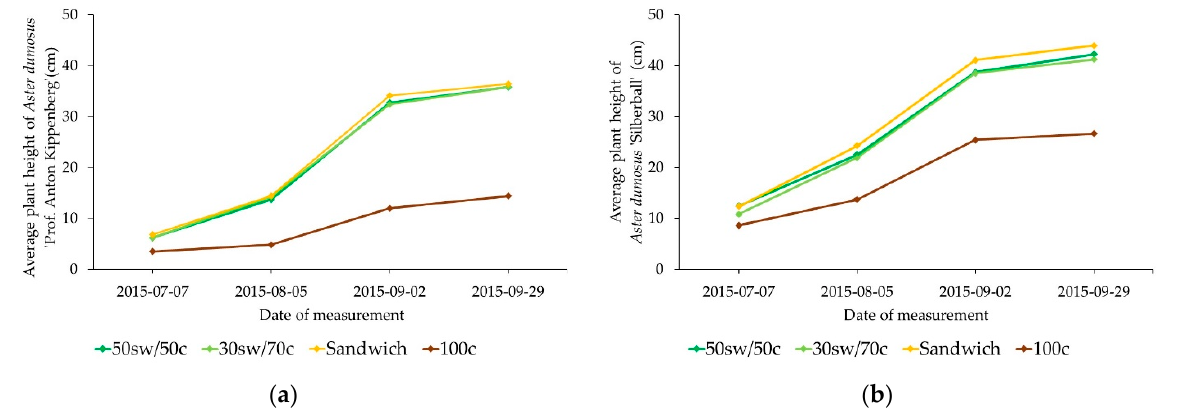
Figure 5. Effect of the different vegetation mats on the average plant height of ( a ) Aster dumosus ‘Prof. Anton Kippenberg’ and ( b ) Aster dumosus ‘Silberball’.